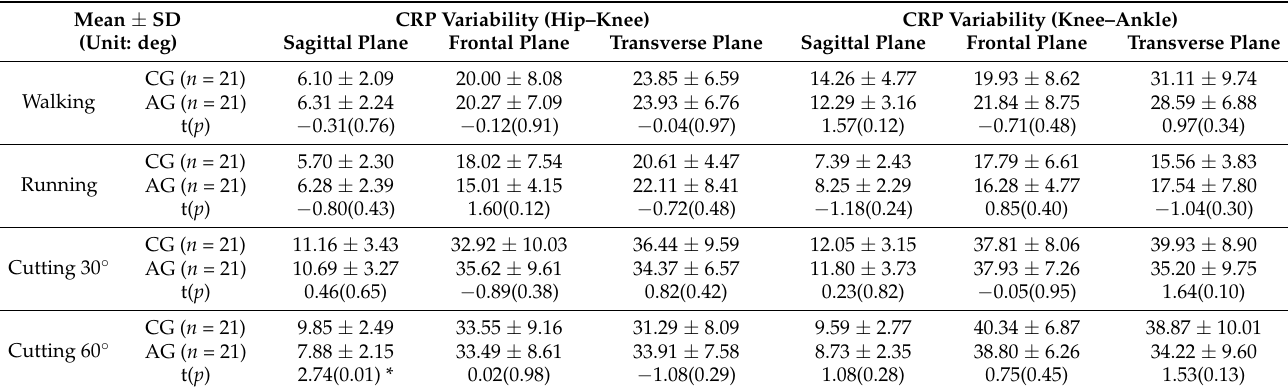
Table 3. Hip–knee and knee–ankle CRP variability by movement